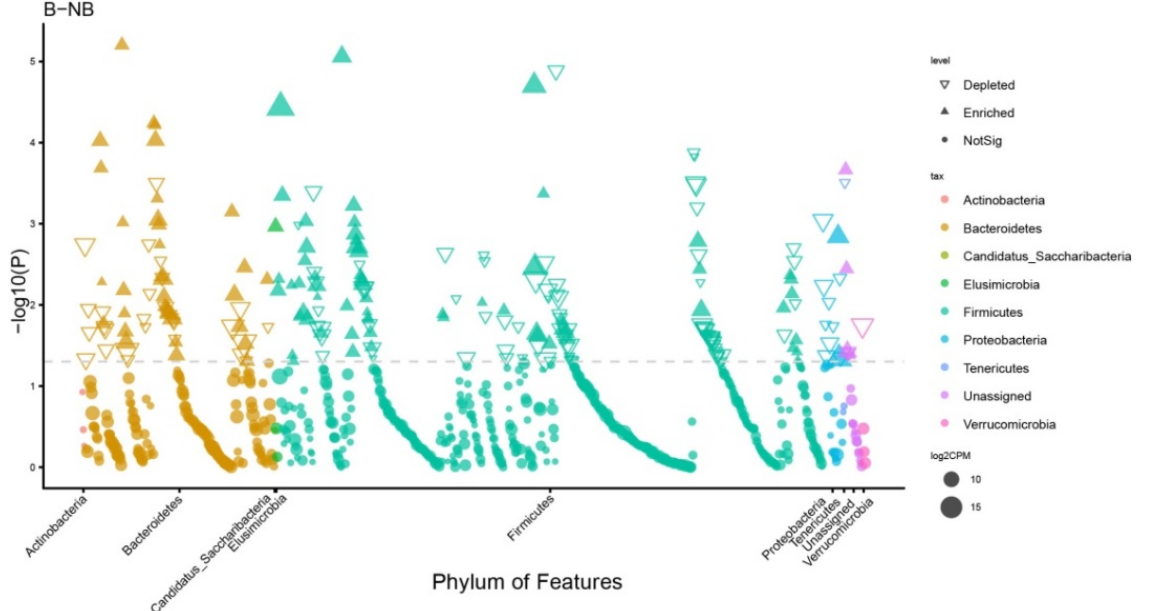
Figure 3. Manhattan plot of the different microbiota at the phylum level. The group of the non-breeding season (NB) was used as the control, and the group of the breeding season (B) was compared with it. The color of each dot represents different taxonomic of the ASVs at the phylum level, and the size of the dot represents the relative abundance of ASVs, takes log2CPM. CPM counts per million. The shape of the dot indicates the type of change.